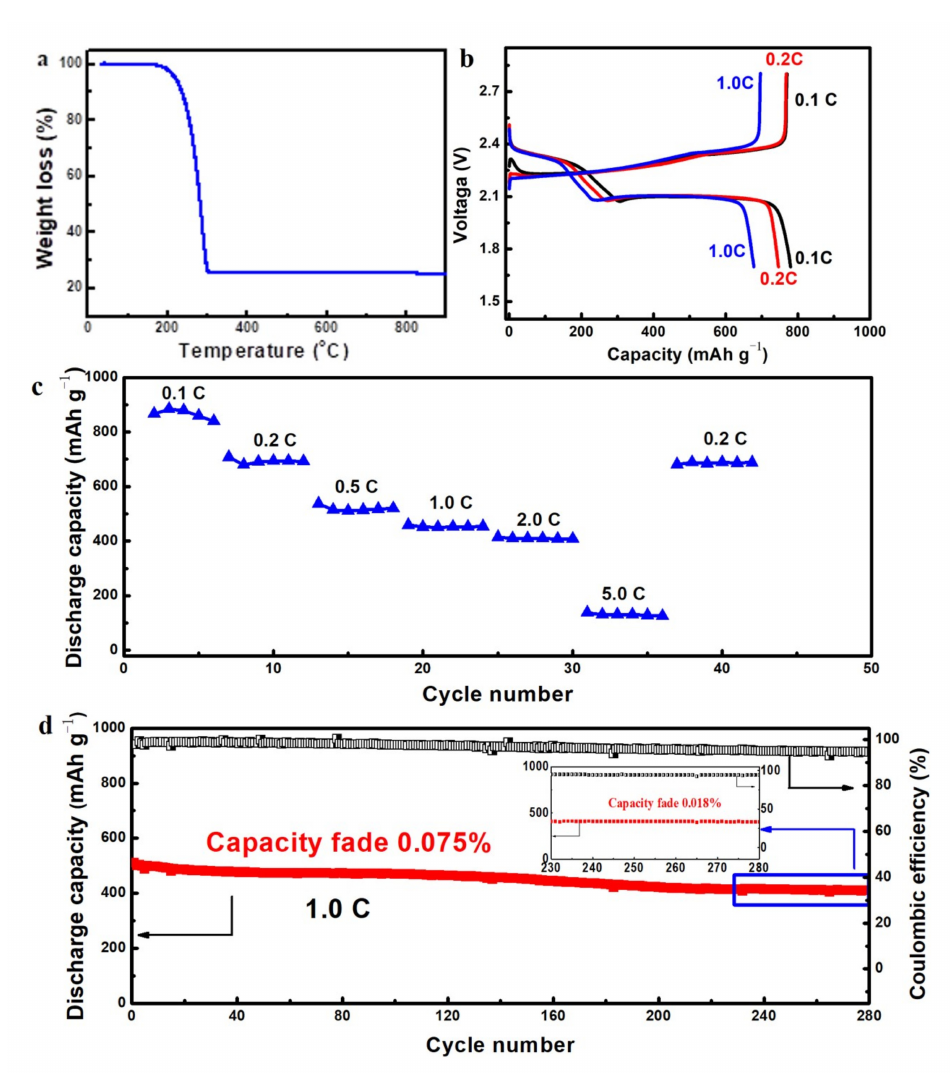
Figure 9. Electrochemical performance of 3DGNs/S cathodes. ( a ) TG curve of the C–S composite measured in an inert atmosphere. ( b ) Charge/discharge curves and ( c ) rate performance curves for the samples at different current densities. ( d ) The cyclic performance and coulombic efficiency of the cathode at a current density of 1.0